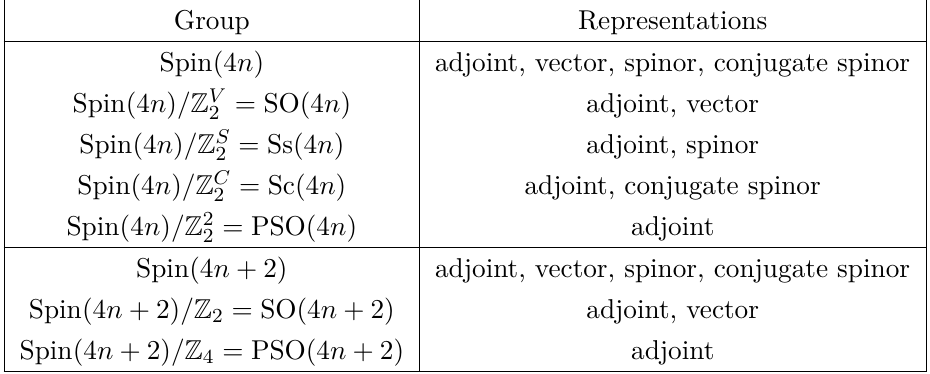
Table 19. D N representations of some groups. Ss(4 n ) and Sc(4 n ) are the semispin groups. We have the particular cases Ss(4) = SU(2) × SO(3) and Ss(8) ’ SO(8) by triality. PSO(16) ⊂ Ss(16) ⊂ E 8 (while SO(16) 6⊂ E 8